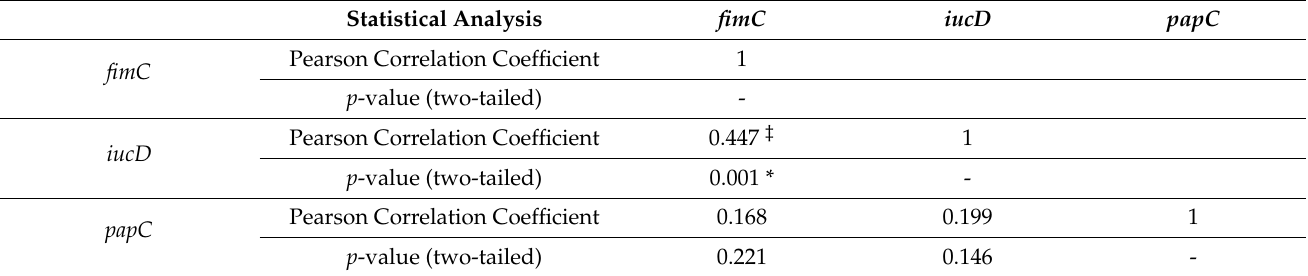
Table 2. Pearson correlation coefficients for pairs of APEC-associated virulence genes isolated from fecal matter of migratory